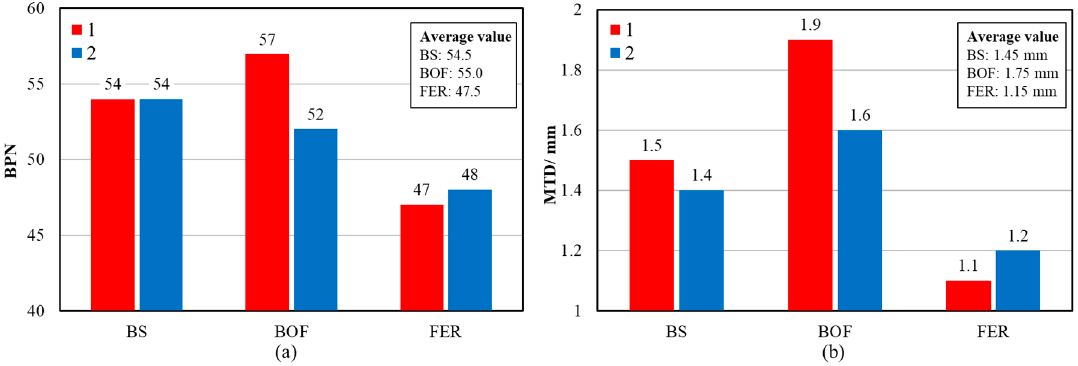
Figure 9. Three-dimensional models of chip seal made of basalt ( a ), BOF slag ( b ) and FER slag ( c ).